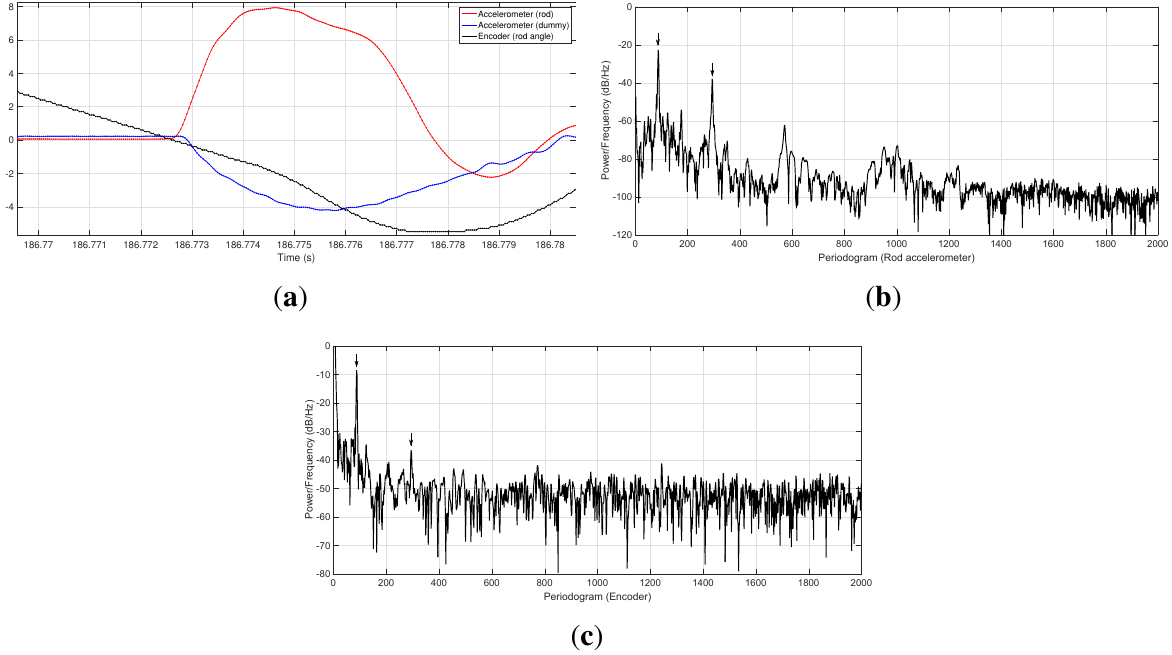
Figure 10. ( a ) Signals at the instant of impact, with a more detailed time scale; ( b ) Spectral density of the rod accelerometer during one rod oscillation period after the impact; and ( c ) the same spectral density but computed from the optical encoder